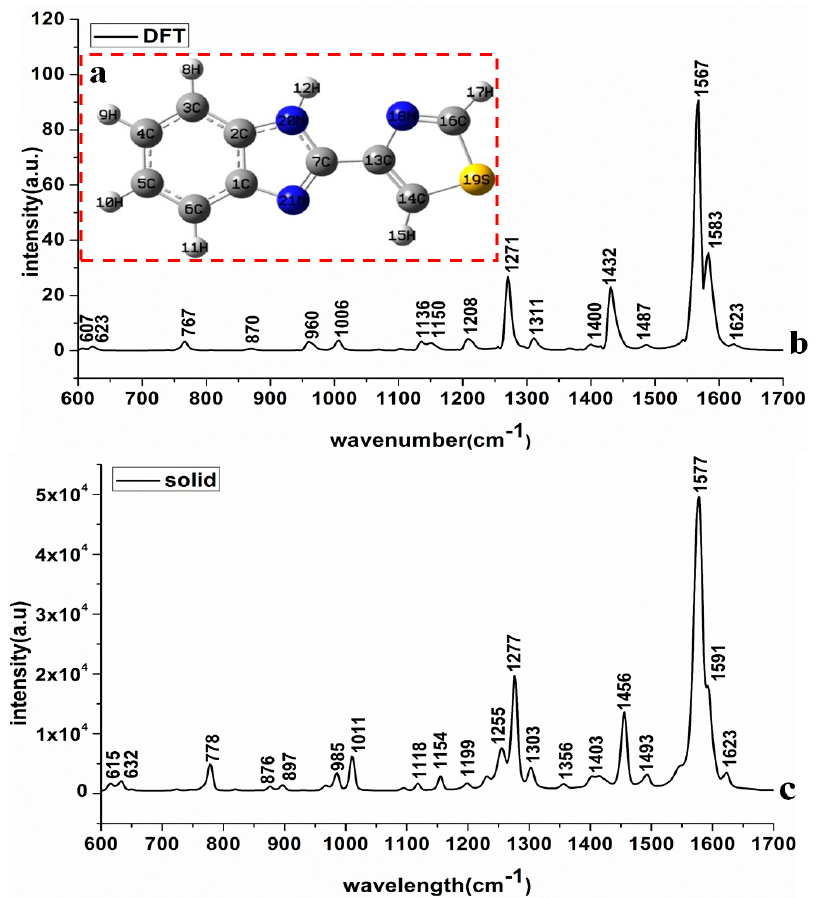
Figure 1. ( a ) Simulated molecular structure of Thiabendazole (TBZ) by density functional theory (DFT); ( b ) the theory calculation by DFT; ( c ) Raman spectroscopy (RS) of TBZ solid.